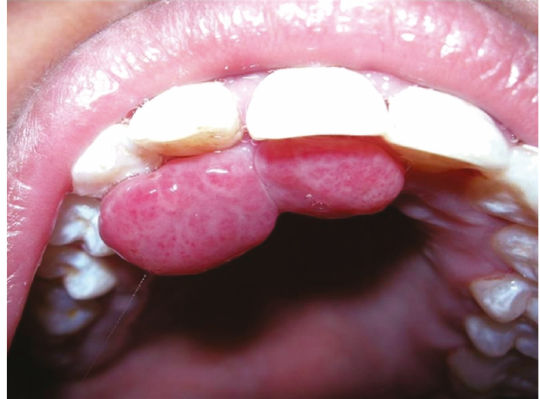
Figure 1: Preoperative intraoral view.